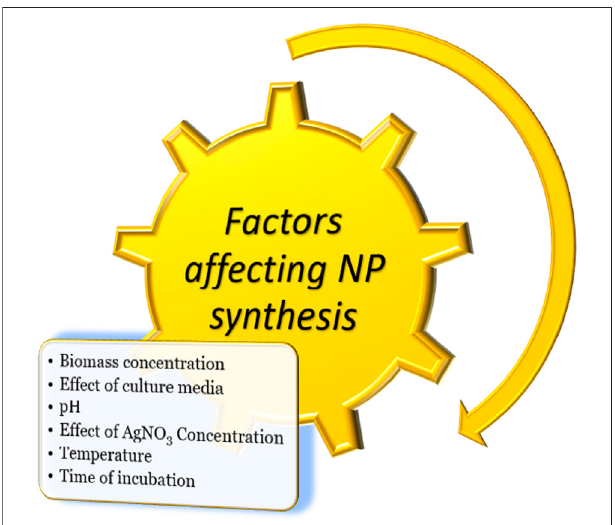
FIGURE 1 | Factors that have effect on synthesis of metallic